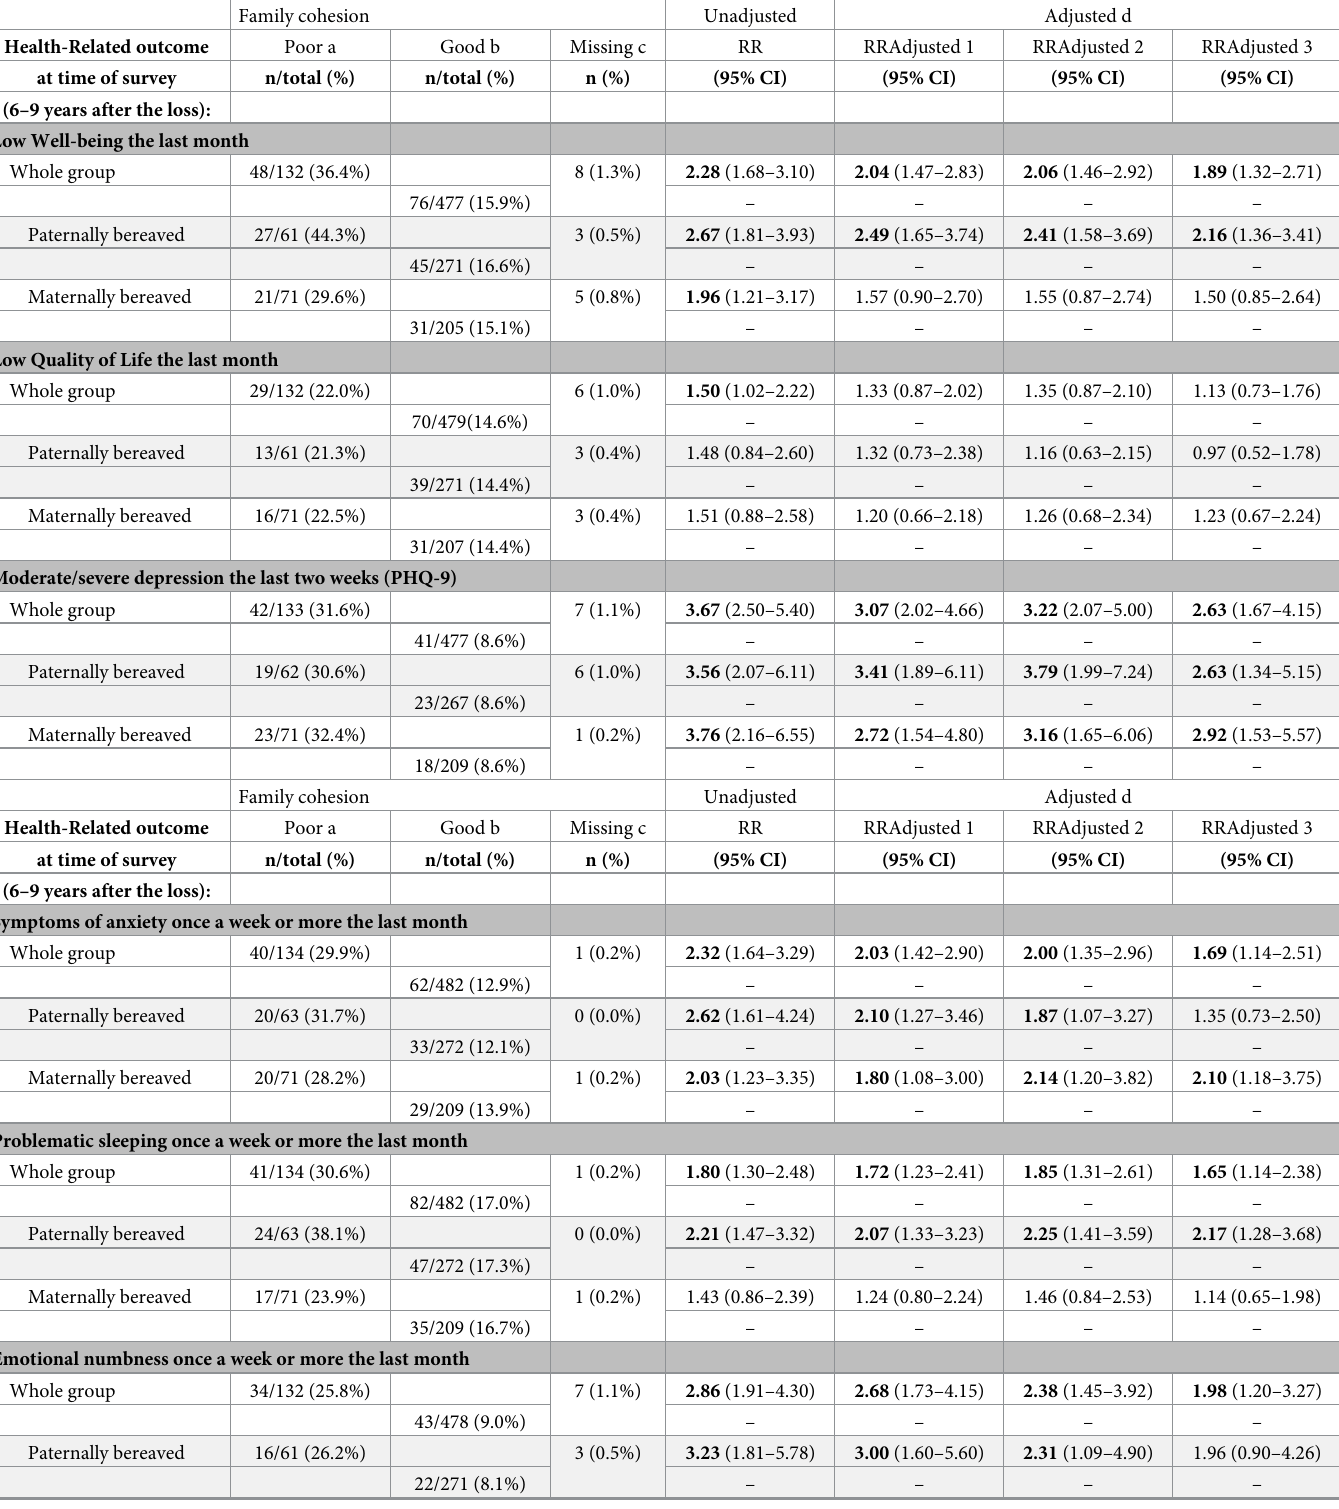
Table 3. Self-reported family cohesion the first year after the loss of a parent to cancer and long-term health-related